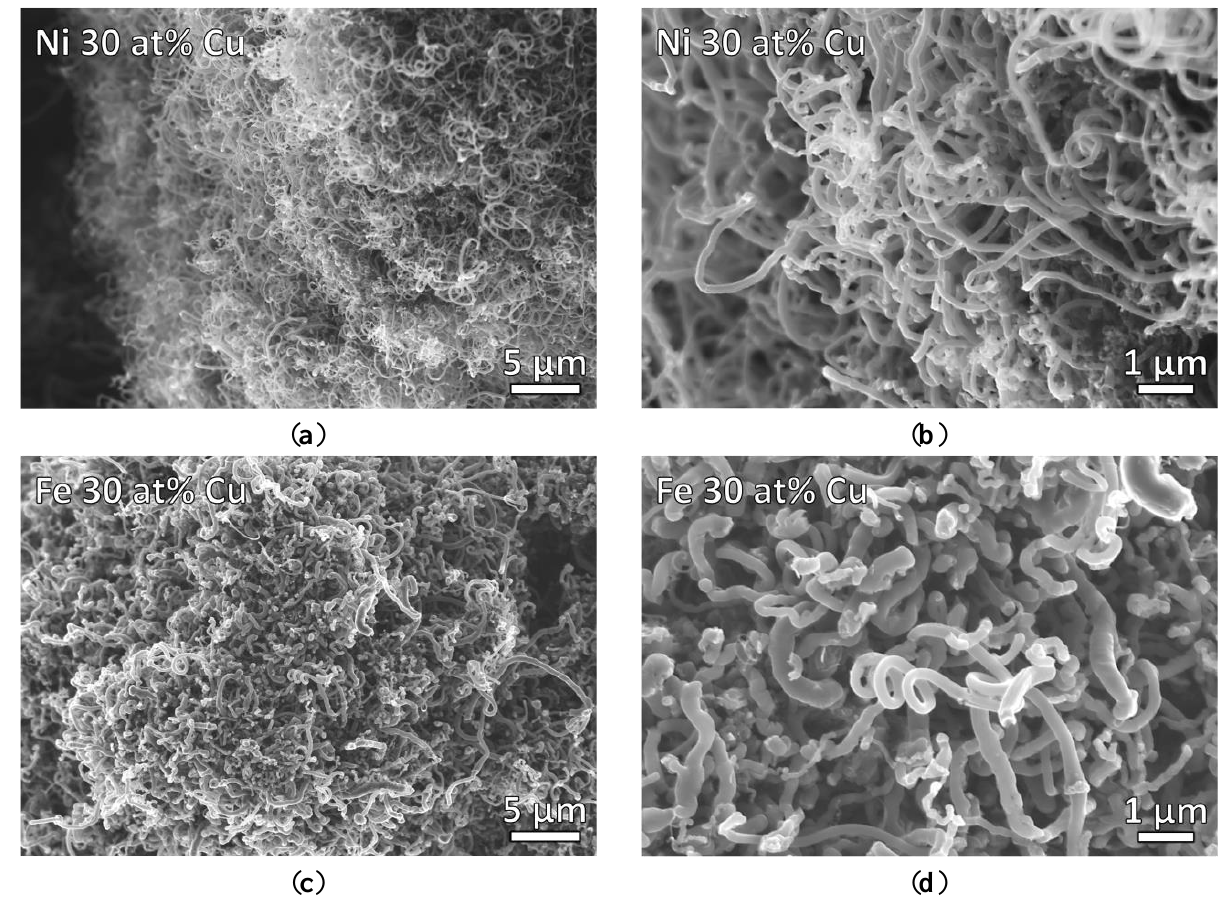
Figure 9. Carbon nanofibers deposited on Ni 30 at% Cu ( a , b ) and Fe 30 at% Cu ( c , d ) at 550 °C with C H :H (4:1). Both catalysts were milled for 4 h before the 2 4 2